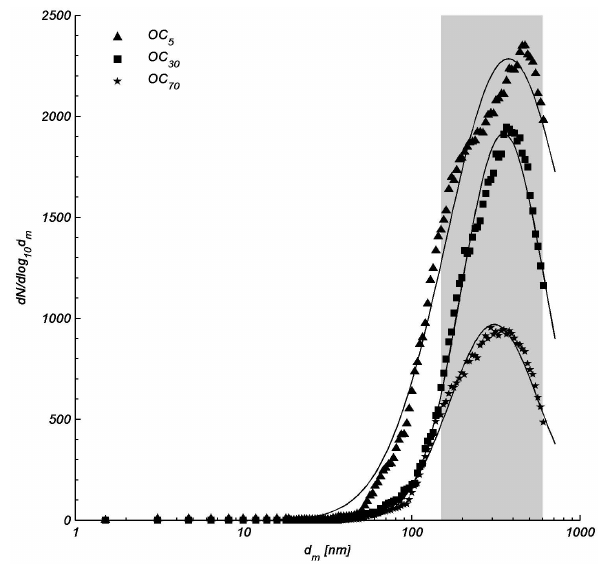
Fig. 2. Size distributions of CAST soot as measured with an SMPS; 5% (triangle), 30% (square) and 70% (star) organic carbon (OC) content after growth in the NAUA aerosol chamber prior to injection into the AIDA aerosol chamber. Area enclosed in grey shows the detection range of the SP2.